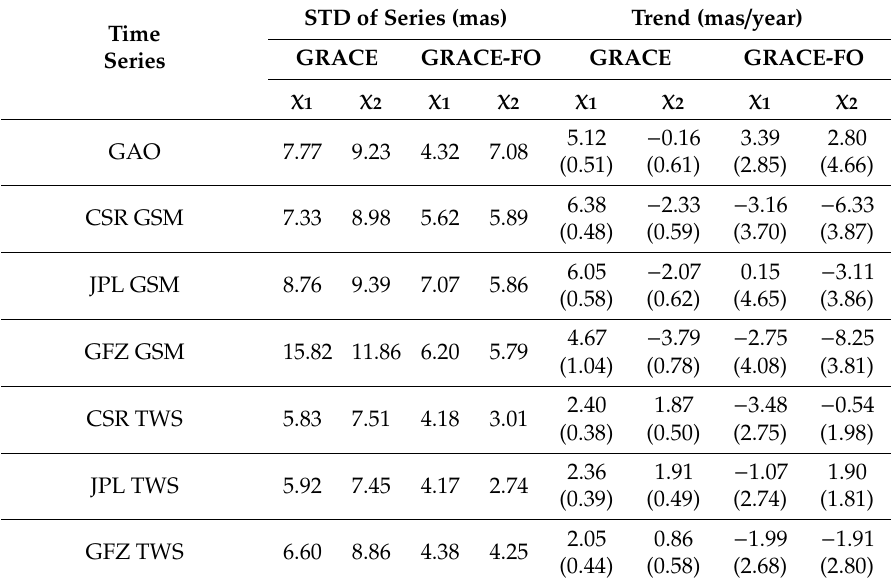
Figure 5. Maps of RMS of differences between the mean GRACE-FO solution (mean of data from CSR, JPL, and GFZ) and ( a ) HAM/CAM from CSR, ( b ) HAM/CAM from JPL, and ( c ) HAM/CAM from GFZ for 2019 (initial period of the GRACE-FO mission). The values are given in mas. Table 2. Standard deviation (STD) of GAO and HAM / CAM (from GSM and TWS) series and trends in GAO and HAM / CAM (from GSM and TWS) series. Trend errors are given in brackets. STD of Series (mas) Trend (mas / year) Time GRACE GRACE-FO GRACE Series